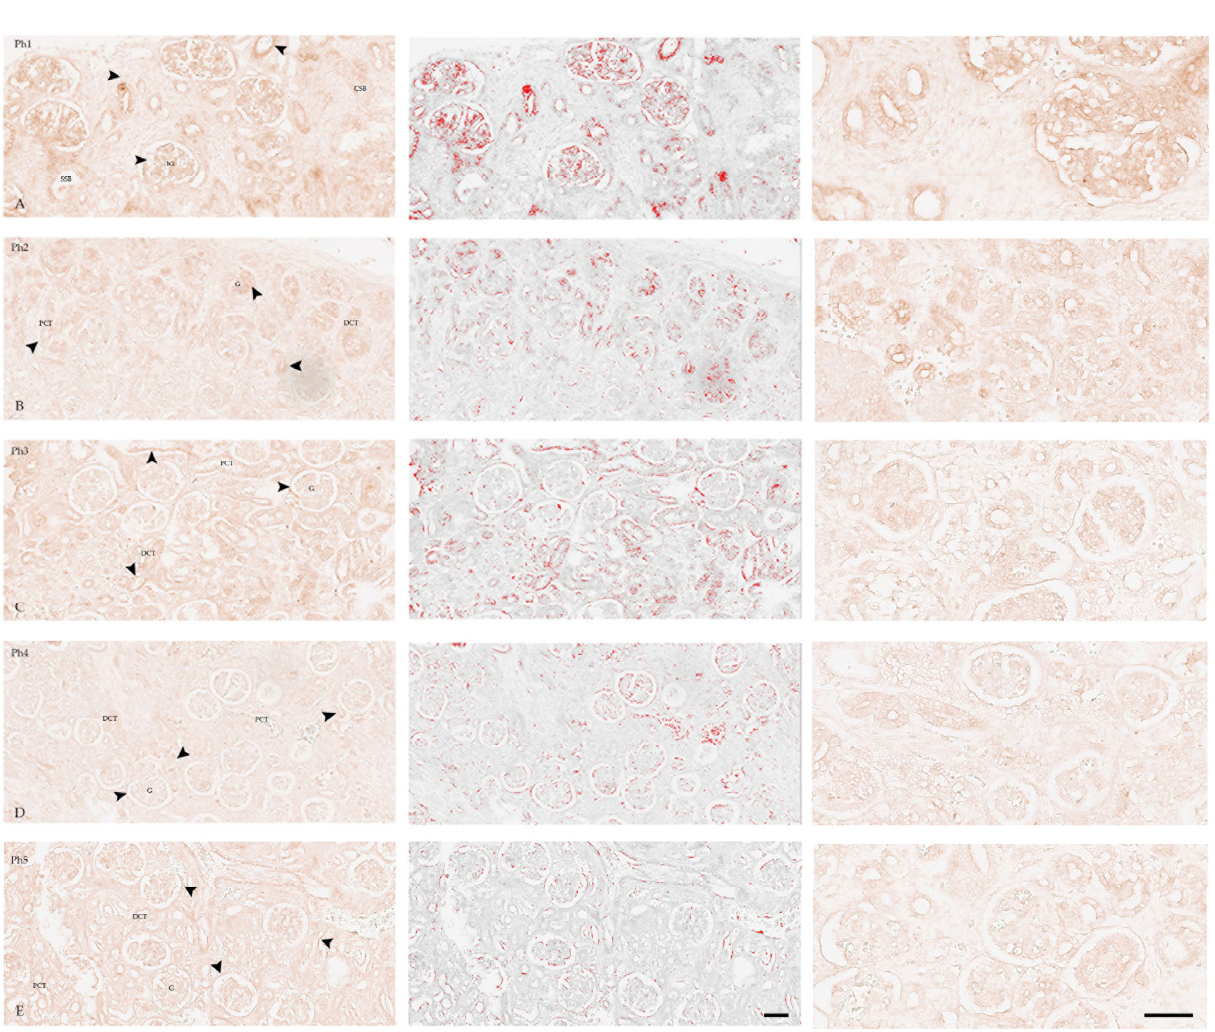
Figure 5. Human fetal ( A – D ) and postnatal ( E ) kidneys stained with KIF12 (left and right), images highlighting the positive signal (red) that were used for the analysis of the area percentage of positive signal, obtained by subtraction of the median filter and thresholding (middle). Expression of KIF12 (arrows) was seen in glomeruli (G), proximal convoluted tubules (PCTs), distal convoluted tubules (DCTs), immature glomeruli (IG), and S-shaped bodies (SSBs) in phase one (Ph1), phase two (Ph2), phase three (Ph3), phase four (Ph4), and phase five (Ph5). Developmental phases (Ph1–Ph4) mostly correspond regarding intensity and localization of KIF12. Scale bar is 40 µ m. ( A , B ) Individual cells of IG strongly expressed KIF12; ( C , D ) A less intense signal can be seen in Ph3 and Ph4; ( E ) In Ph5 is seen diffuse staining of Bowman’s capsule and visceral epithelial cells, as well as luminal side of PCTs. (DAB/ICH without hemalaun counterstain, columns 1 and 2 magnification 20 × , column 3 magnification 40x). For negative control, see Supplementary Figure S1.